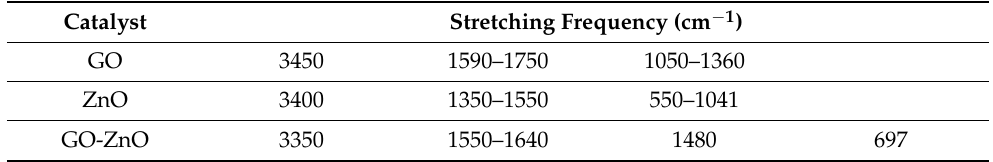
Figure 1. FT-IR spectra of photocatalysts (GO, ZnO and GO-ZnO) derived from the biomass. Table 1. Analysis of the vibrational frequency of the catalysts.